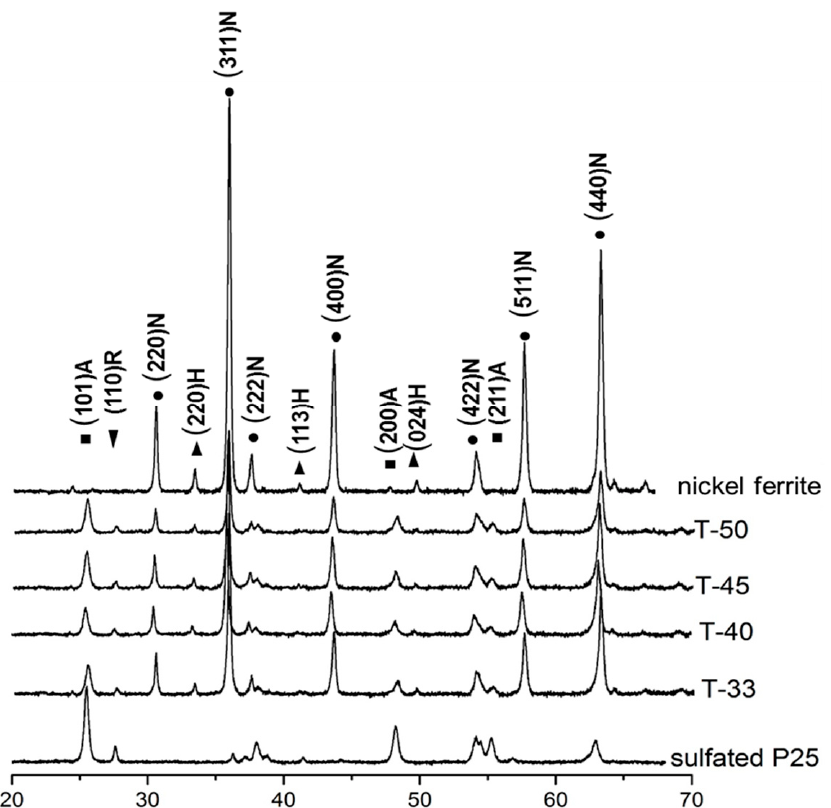
Figure 1. XRD patterns of composite catalysts, nickel ferrite and sulfated P25.